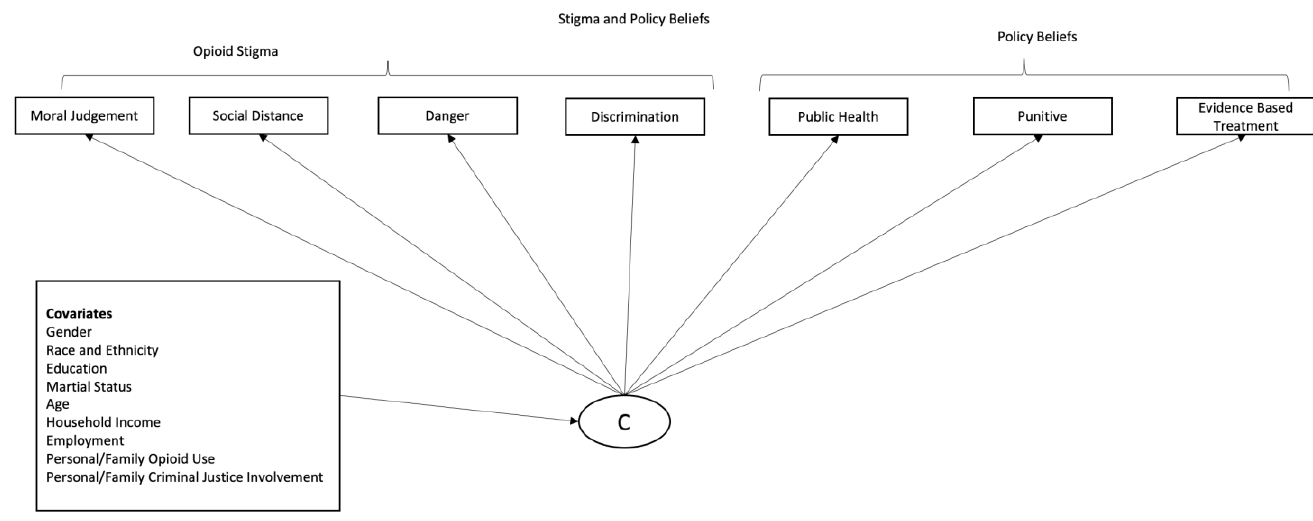
Figure 1. Groups of individuals endorsing similar stigma and policy beliefs.